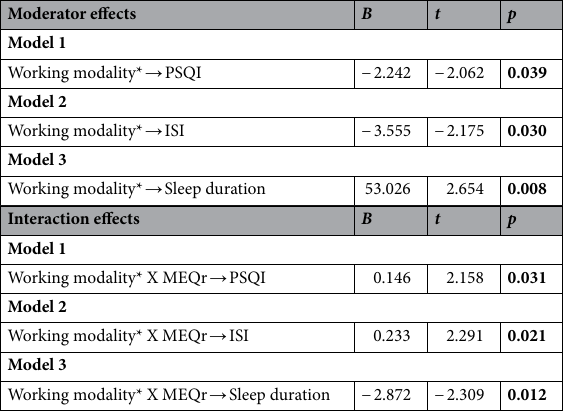
Table 4. Moderator and interaction effects for the three models, including sleep quality (PSQI score; Model 1), insomnia symptoms (ISI score; Model 2), and sleep duration (min; Model 3) as mediators, whilst accounting for the effects of age and gender. * Office working was used as reference for “Working modality” factor. PSQI Pittsburgh sleep quality index, ISI insomnia severity index, MEQr morningness-eveningness questionnaire- reduced version. Significant values are in bold.